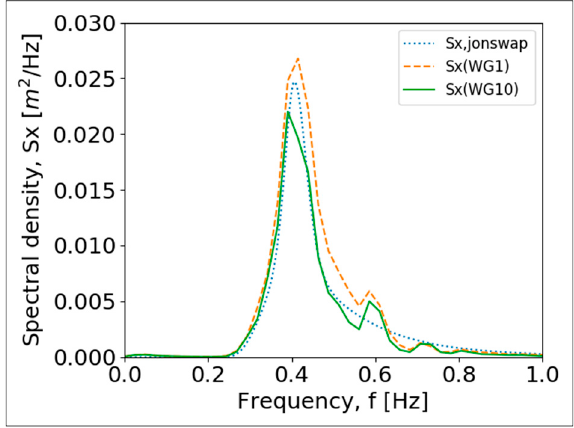
Figure 15. Spectral density of the target JONSWAP spectrum, Sx, jonswap, and free surface measurements of WG1, Sx (WG1), and WG10, Sx (WG10), for test 04_B over the frequency, f .